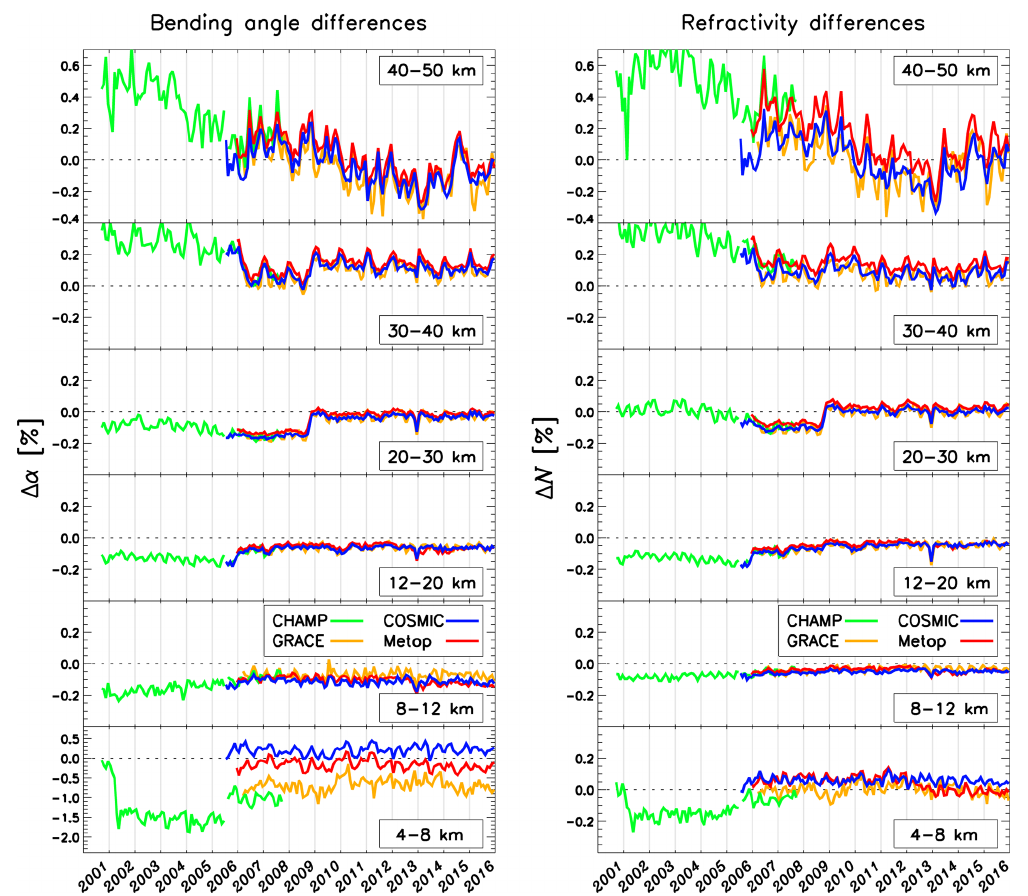
Figure 5. Globally averaged monthly mean bending angle (left panels) and refractivity (right panels) differences with respect to ERA- Interim, for the four RO missions included in the ROM SAF CDR. From bottom to top, the panels show vertically averaged differences in for refractivity. Note that for the lowest bending angle panel (left column), the vertical axis has been compressed to accommodate the larger differences between the missions.